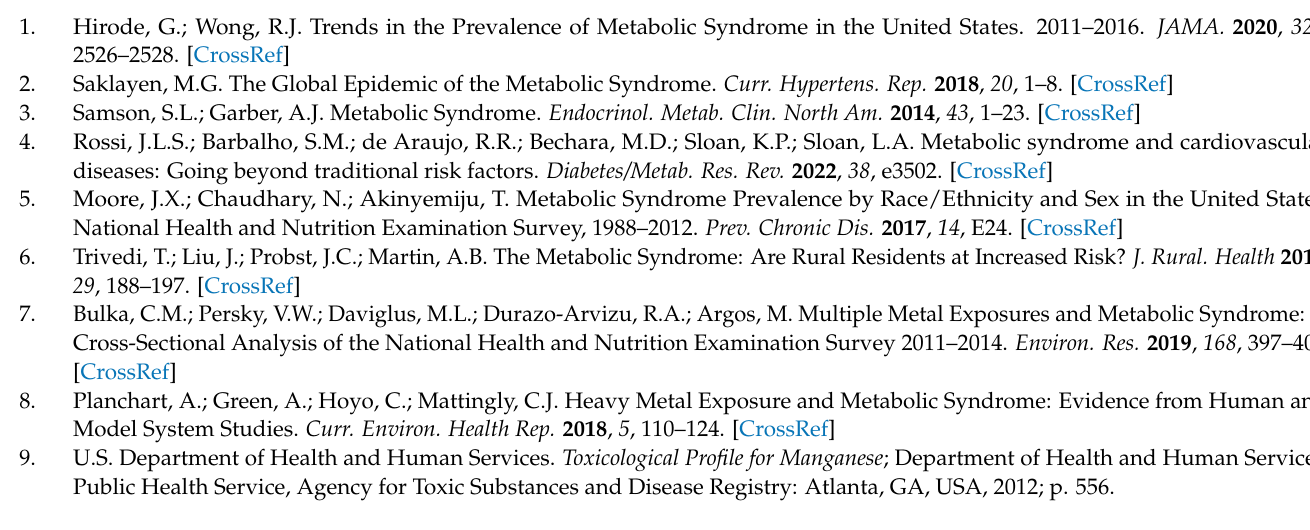
Figure S1: Exposure-response functions of natural log-transformed urinary metal concentrations and odds estimates of metabolic syndrome (MetS) (n = 1,478), Table S2: Crude longitudinal associations between baseline quartiles of manganese and metabolic outcomes, Table S3: Adjusted longitudinal associations between baseline quartiles of manganese and metabolic outcomes among participants with Mn levels above the limit of